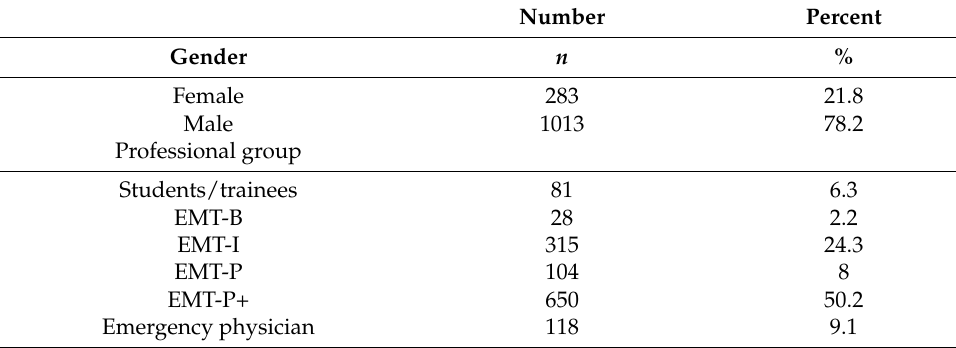
Table 1. Demographic